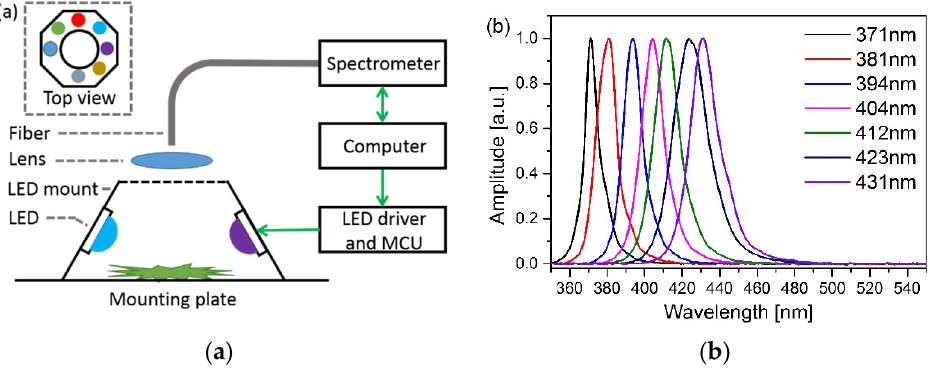
Figure 1. ( a ) Schematic of the multi-channel LED-induced fluorescence system. ( b ) The spectra of the seven excitation LEDs.